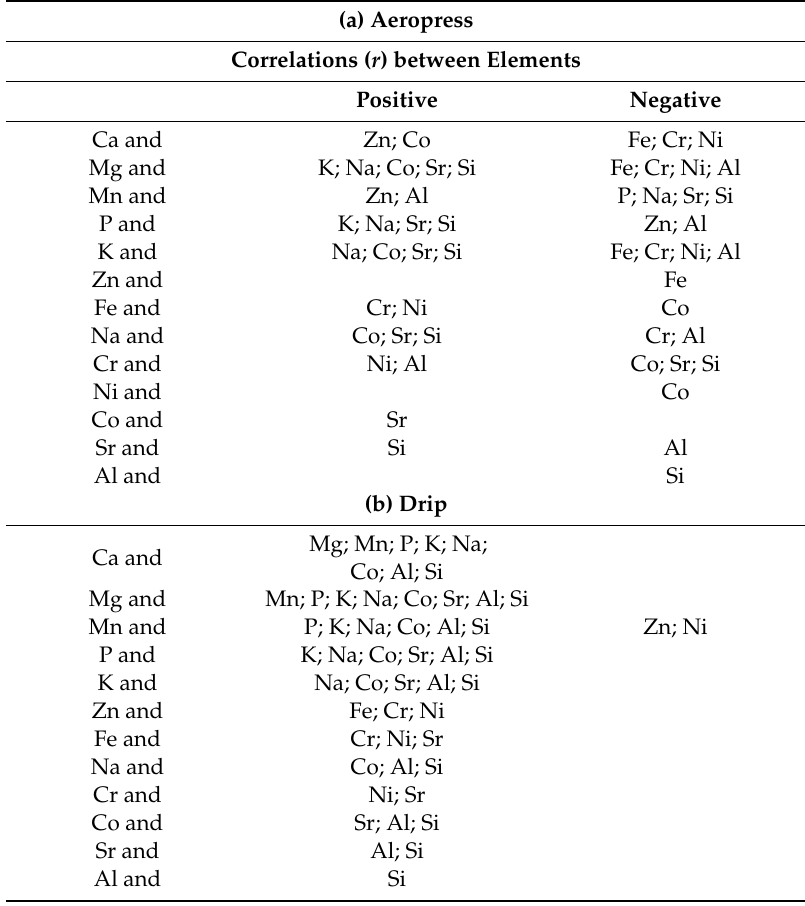
Table 3. Statistically significant (at p ≤ 0.05) correlation ( r ) between elements in co ff ee: ( a ) Aeropress, ( b ) drip, ( c ) espresso, ( d ) simple infusion, and ( e ) French